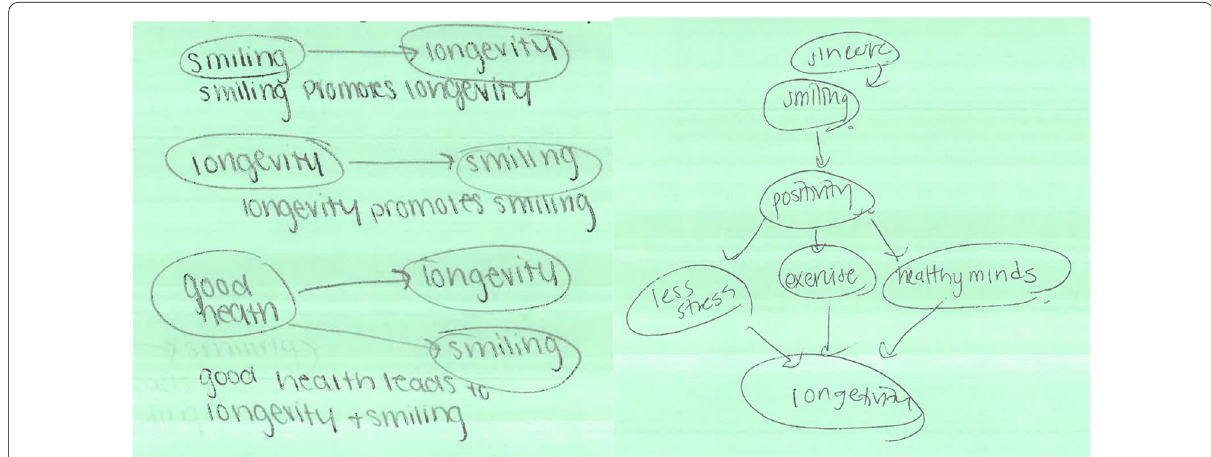
Fig. 4 Example diagrams depicting alternative causal theories from a student in the post-test session. On the left, diagrams showing direct cause, reverse cause, and third-variable theories; on right, a more complex theory with multiple steps and